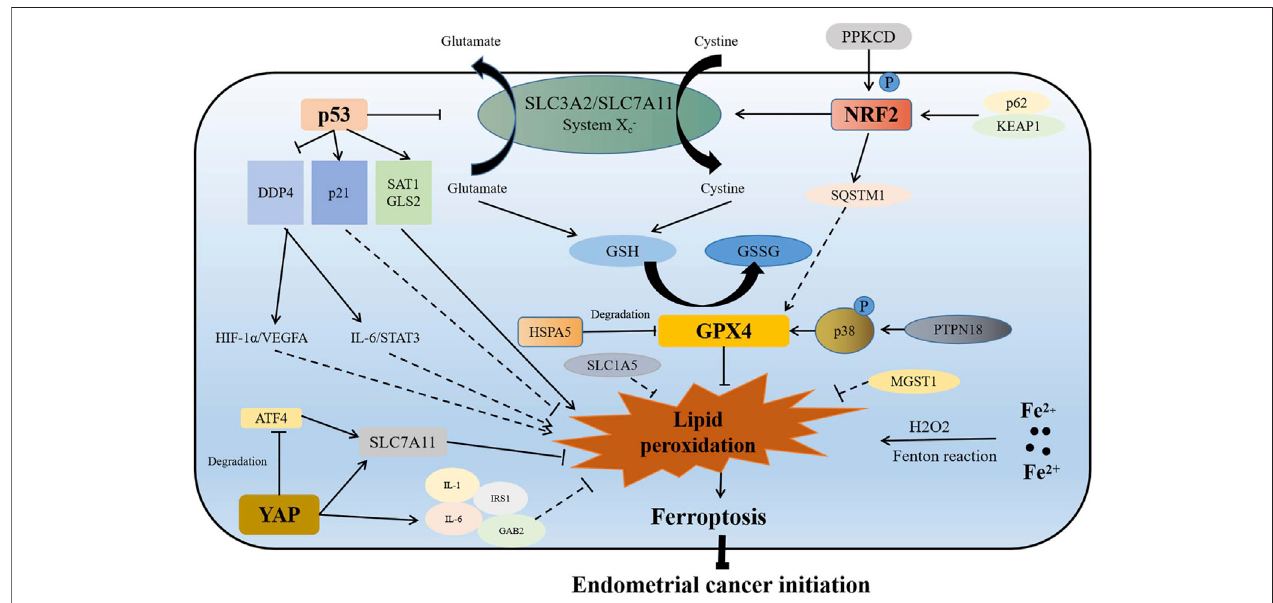
FIGURE1| Associationofferroptosiswithinitiationofendometrialcancer.Ontheonehand,p53directlyreducestheproductionofGSHbyinhibitingthefunctionof the SLC3A2/SLC7A11 complex, which inhibits the function of GPX4 to promote lipid peroxidation and ferroptosis. On the other hand, p53 indirectly targets p21, SAT1, GLS2, and DDP4, which may regulate ferroptosis and endometrial cancer initiation by activating the HIF-1 α /VEGFA and IL-6/STAT3 signaling pathways. When Nrf2 is overexpressed or phosphorylated activated by p62/KEAP1 or PPKCD, it inhibits lipid peroxidation and ferroptosis by promoting the expression of SQSTM1, and enhancing the function of SLC7A11 and GPX4. GPX4 is a ferroptosis inhibitor, which is regulated by HSPA5 and PTPN18. GPX4 plays an important role in inhibiting ferroptosis and promoting initiation of endometrial cancer. Increase of intracellular iron results in lipid peroxidation and ferroptosis by Fenton reaction. MGST1, SLC1A5, and YAPare also inhibitors offerroptosis. YAPpromotes theexpression ofSLC7A11directly orthroughinhibiting ATF4degradation.YAP also promotes the increase of IL-6, IL-1, IRS1, and GAB2, which may inhibit lipid peroxidation to promote endometrial cancer initiation. P in the graph represents